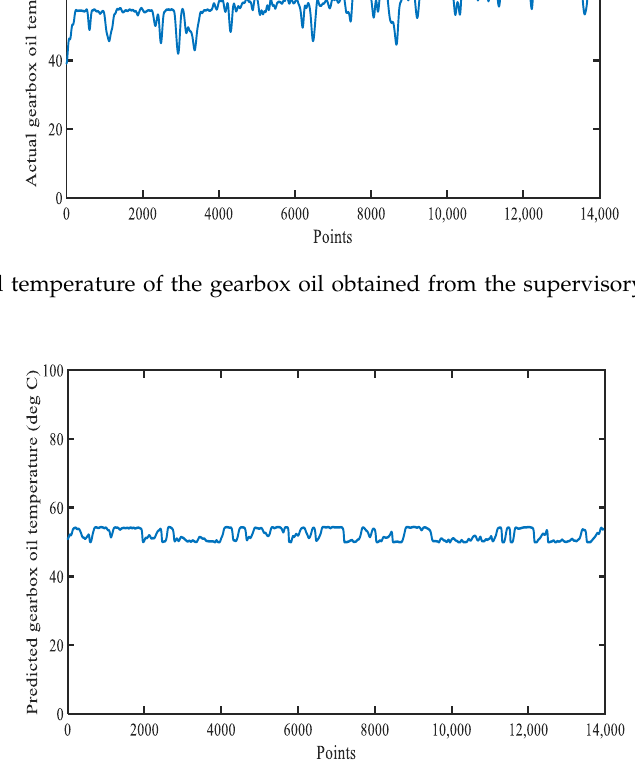
Figure 12. Residual temperature of the gearbox oil. 4.3. CASE 2: Condition Monitoring Based on the Generator Bearing Temperature To further validate the proposed method, condition monitoring based on the gearbox bearing temperature is adopted. Figure 13 shows the wind speed measured at the wind farm, and corresponding wind turbine power output and actual air temperature are given in Figures 14 and 15, respectively. In Figure 16, the MD values combination of wind speed, power generation, and air temperature are shown. Figure 17 illustrates the actual gearbox bearing temperature from the SCADA system in the wind turbine with a gearbox bearing fault. Figure 18 shows the LSTM prediction model output gearbox bearing temperature. Figure 19 describes the residual signal of the gearbox bearing temperature. It is obvious that the error between the actual gearbox bearing temperature from the SCADA system and from the LSTM prediction model has a rapid increasing trend at sampling point 4000, which indicates a system abnormal occurred in the gearbox bearing.